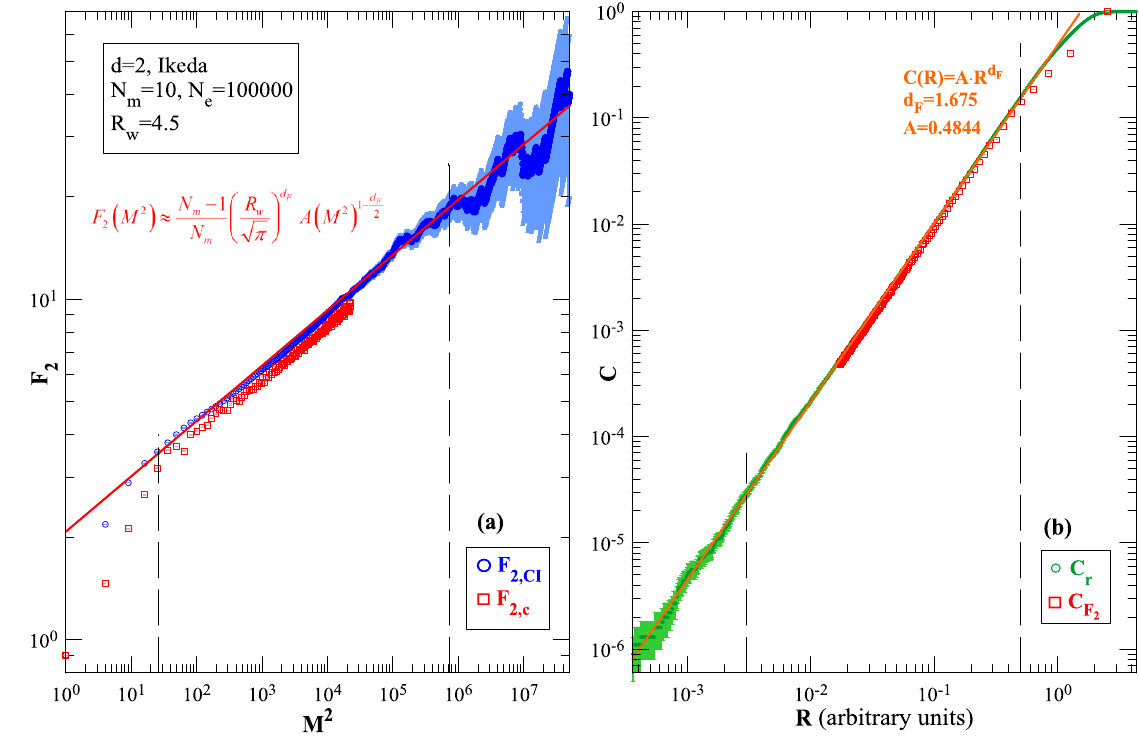
Fig. 9 Analysis of an Ikeda data set of N e = 100 , 000 events and multiplicity N m = 10 in an embedding space of d = 2